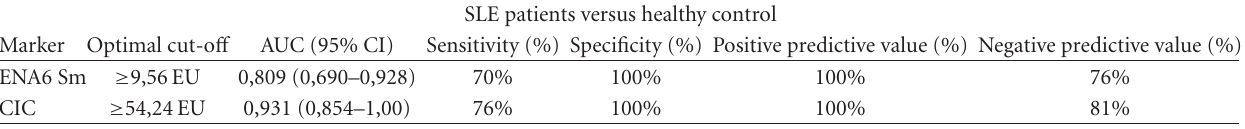
Table 2: Optimal cut-o ff , area under the curve with 95% confidence interval (AUC, 95% CI), sensitivity, specificity, positive and negative predictive value of ENA6, SM, and CIC in di ff erencing between SLE patients and healthy control.